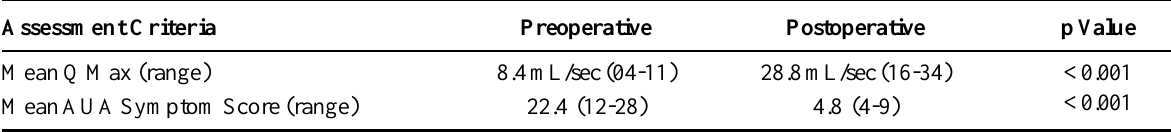
Table 3 – Improvement in Q-max and AUA symptom score after operation. Assessment